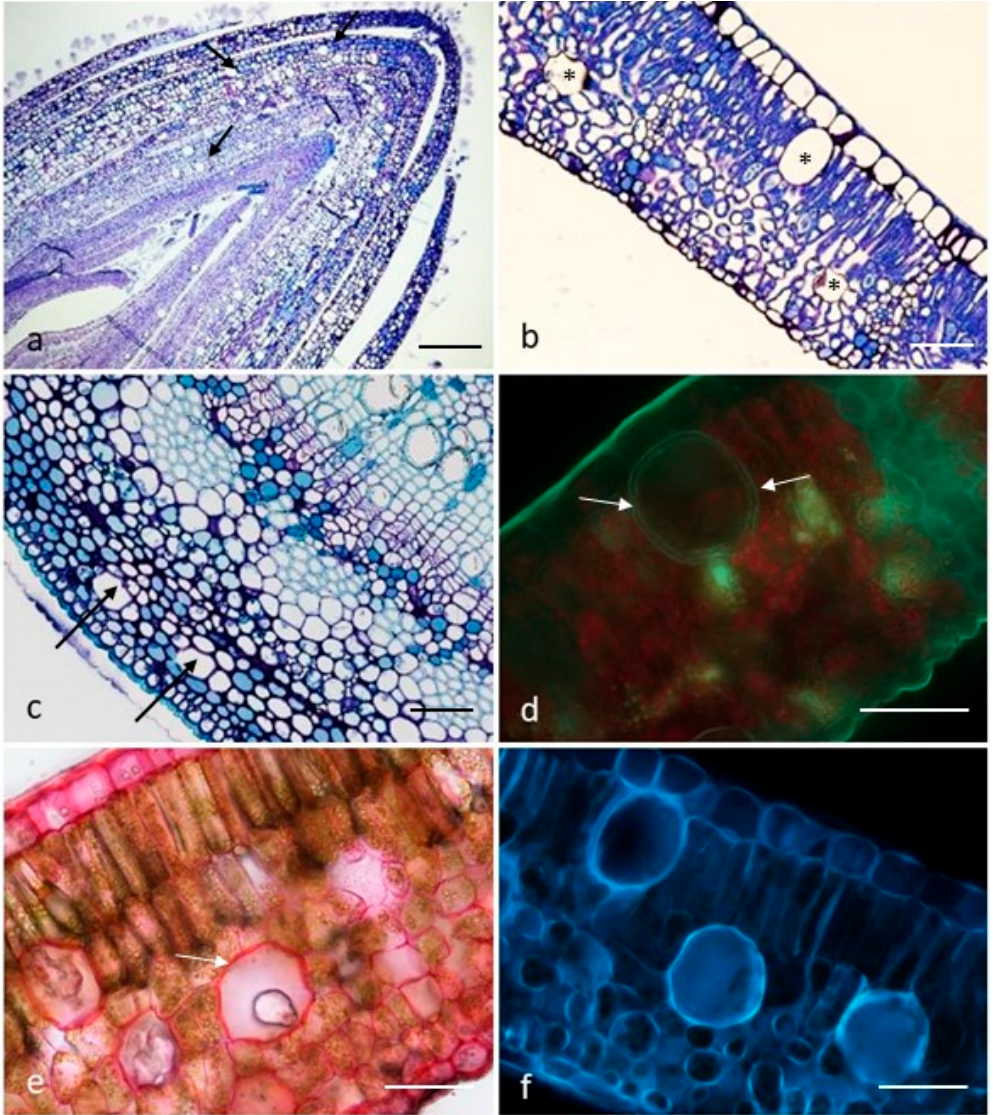
Figure 1. ( a – c ). Transverse sections of a leaf bud ( a ), a full-expanded leaf ( b ) and a young stem ( c ) showing the distribution pattern of the secretory cells (arrows and asterisks). Toluidine Blue. ( d – f ). Transverse sections of full-expanded leaves: primary fluorescence under UV light ( d ), notice the two-layered cell wall (arrows); Ruthenium Red test on the secretory cell walls (arrows) ( e ); primary fluorescence under Blue light ( f ). Scale bars = 200 μ m ( a ); 100 μ m ( c ); 50 μ m ( b , d – f ).